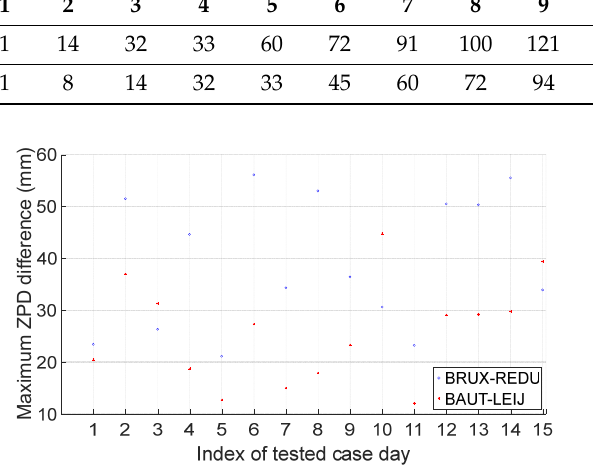
Figure 14. Daily maximum ZPD difference of the two baselines on selected days.